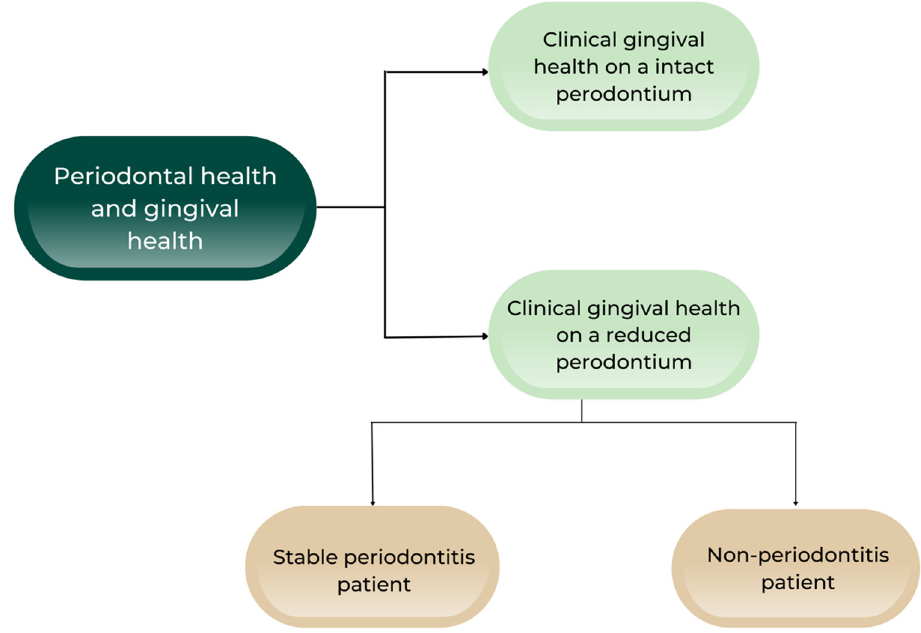
Figure 2. Periodontal and gingival health [14].